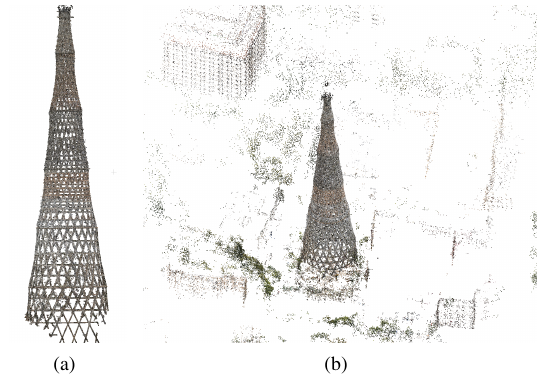
Figure 7. Photogrammetric dense point cloud of Shukhov tower (a), inserted in the sparse cloud of the surrounding area (b). The final image-based dense point cloud on the entire tower, com- posed of ca 5.7 mil. points, is shown in Figure 7. As portions of holes in the point cloud are present.